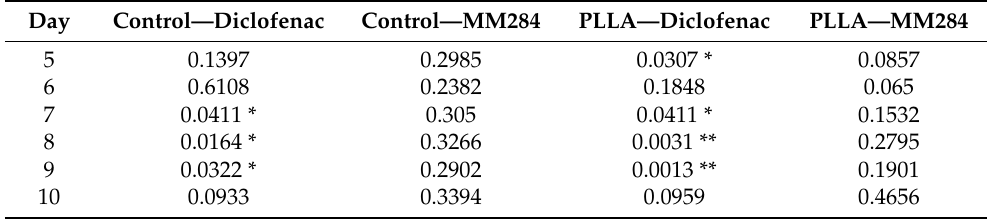
Table 4. p values contact two.